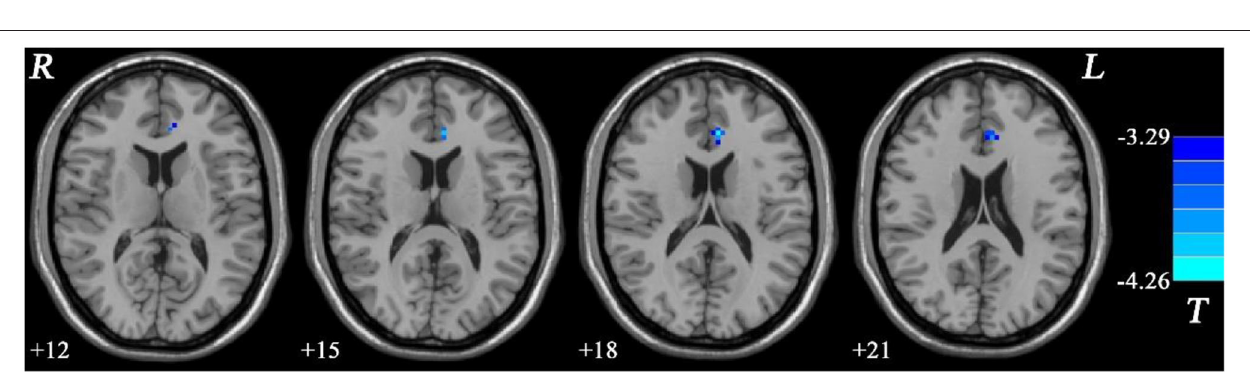
FIGURE 3 | Fractional amplitude of low-frequency fluctuation (fALFF) differences between non-melancholic major depressive disorder (MDD) and healthy controls (HCs). Red and blue represent increased and decreased regional spontaneous activity in the patients, respectively.